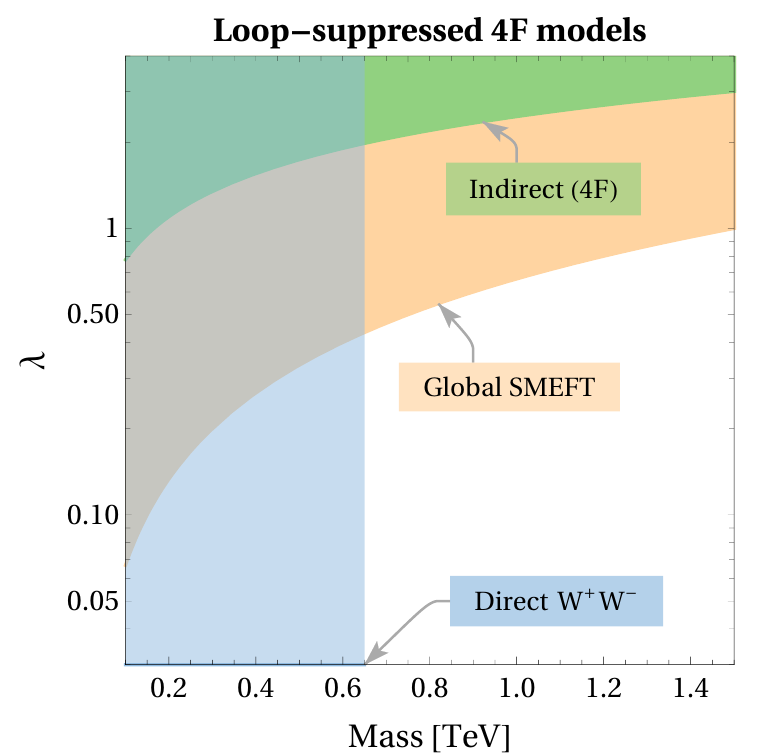
Figure 11. Interplay between indirect low-energy probes, SMEFT global fits, and resonant LHC searches for the EU